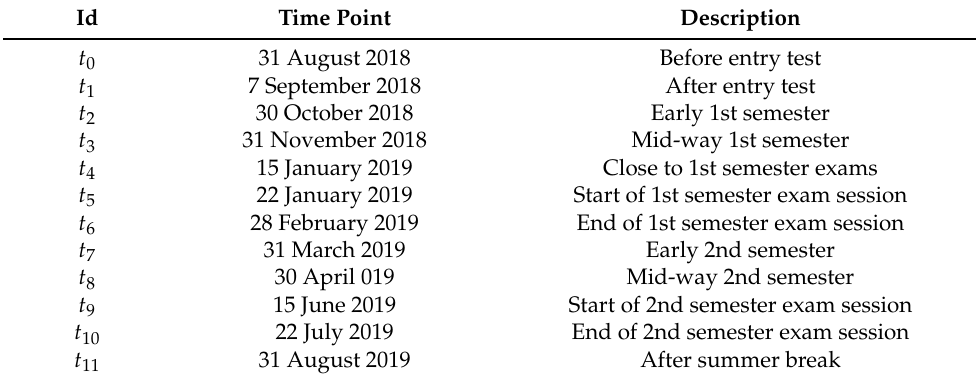
Table 2. Time points of prediction.